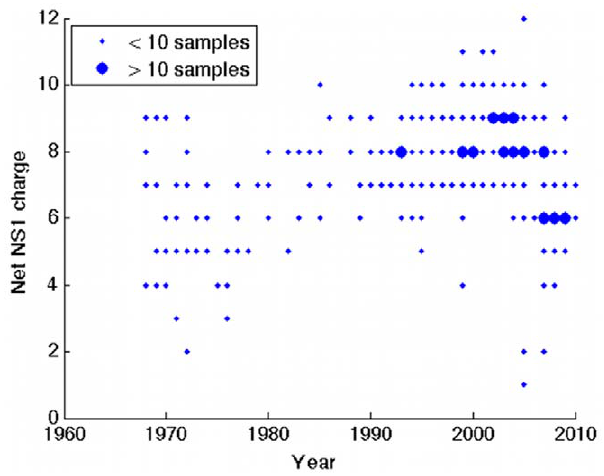
Figure 3. Charge data for the influenza NS1 protein. Restricted to the H3N2 subtype.